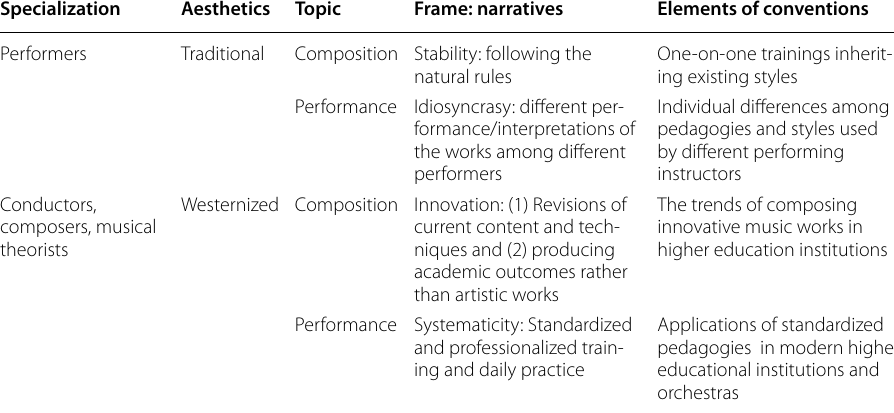
Table 2 Aesthetics and relevant elements of conventions in the Chinese traditional music world Specialization